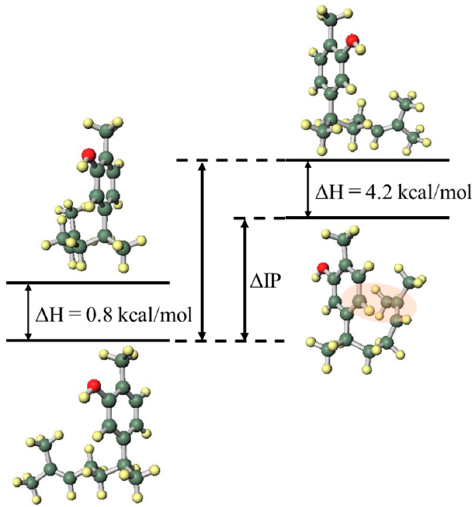
Figure 3. Neutral ( left ) and radical cation ( right ) energy diagrams of xanthorrhizol ( 1 ).